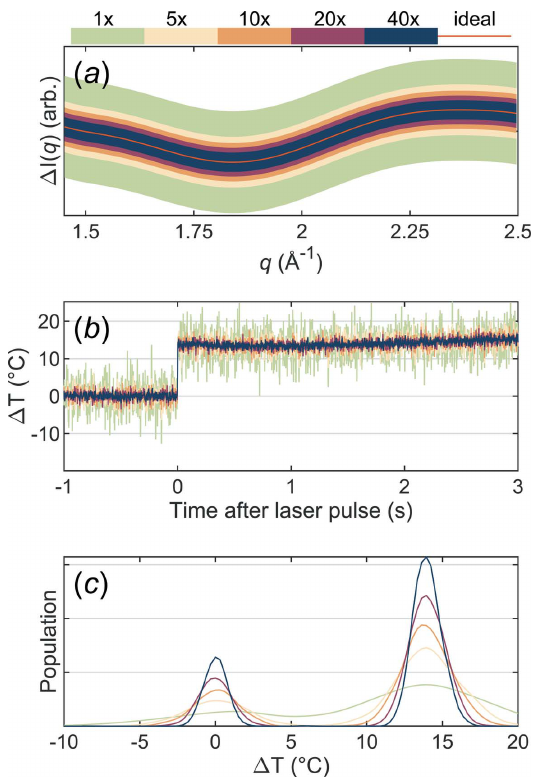
Figure 3 ( a ) The approximate signal-to-noise in the difference scattering signal in the WAXS range for different amounts of X-ray exposure, where 1 (cid:3) refers to a single frame (2 ms exposure), 5 (cid:3) to the average of five such frames, etc . ( b ) The estimated T-jump for different amounts of acquired data for a single step, the average of five steps, etc . ( c ) The data from ( b ) as a density